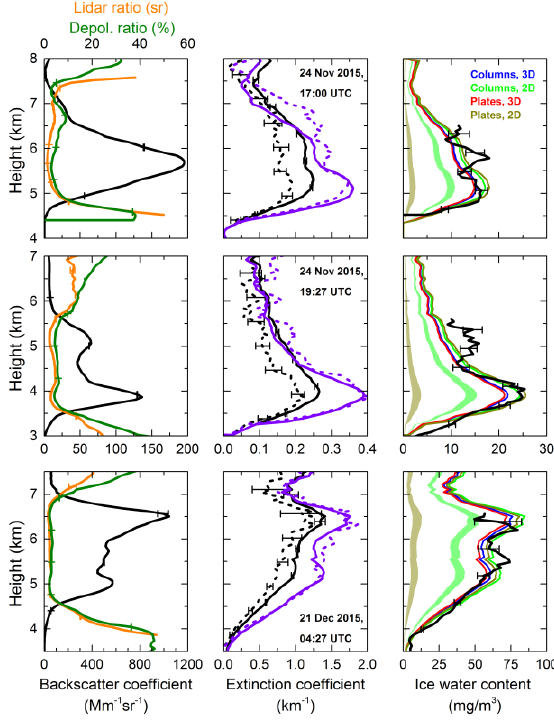
Figure 3. Same as in Fig. 1, but for three observations of 3D cirrus with embedded 2D layer of substantial ice water content. Either 3D, or 2D, plates or columns are assumed, aspect ratios are 0.55 and 1.0 (top, center), and 0.50 and 1.0 (bottom), respectively. Shaded areas illustrate results obtained for thin 2D plates (aspect-ratio range of 0.04-0.08) and elongated 2D columns (2.5-3.0). with RAMSES while thin plates or elongated columns